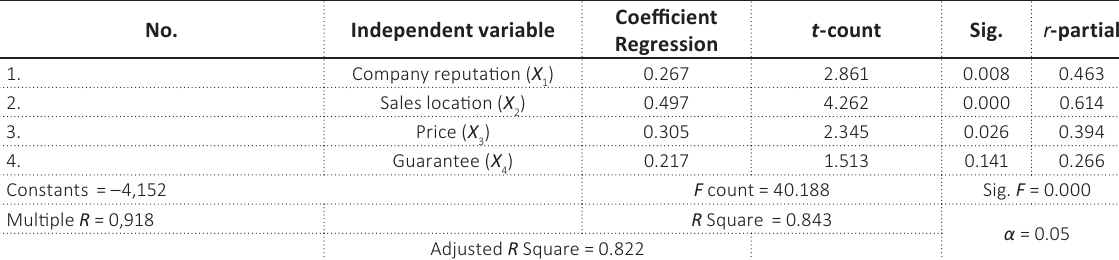
Table 2. Multiple linear regression calculation